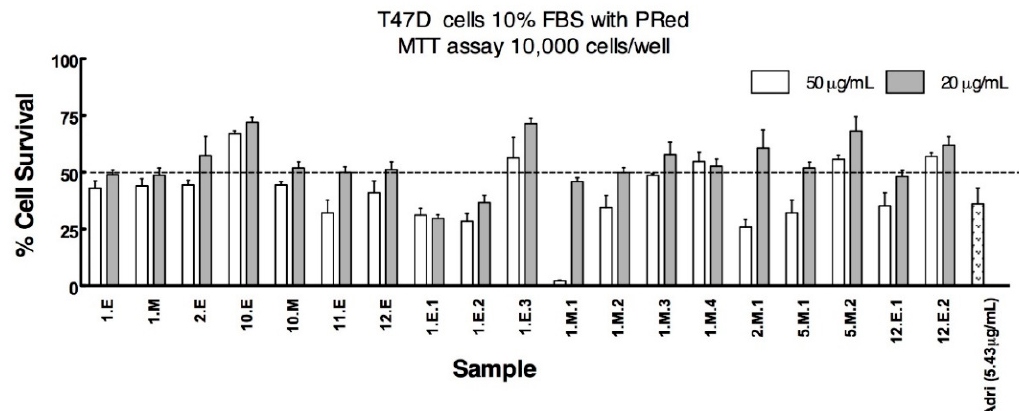
Figure 3. Cell survival of a cytotoxic assay against the T47D breast cancer cell line of different samples tested at two concentrations (20 µg/mL and 50 µg/mL). Adriamycin at 5.43 µg/mL was used as reference.